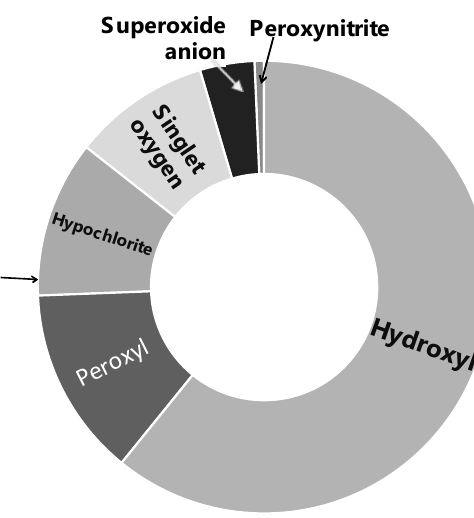
Figure 1. Full spectrum antioxidant capacity